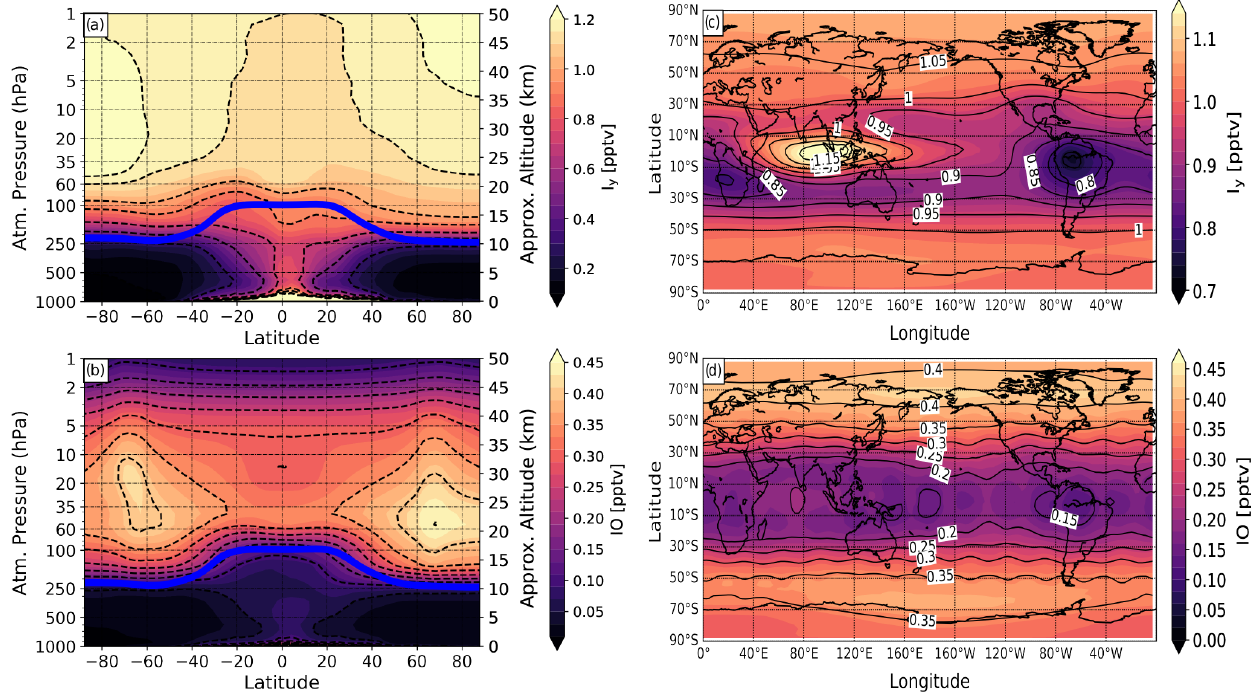
Figure 3. Modeled vertical distribution and global map of total inorganic gas-phase iodine (I y ) and iodine monoxide (IO) simulated with SOCOL-AERv2-I from the experiment with present-day iodine emissions (1 × iodine), averaged for the 2000–2009 period and 10 ensemble members. (a, b) Zonal-mean vertical distributions of I y and IO. (c, d) Global maps of I y and IO averaged for 100–70hPa region. Blue solid line in (a) and (b) : annual mean tropopause